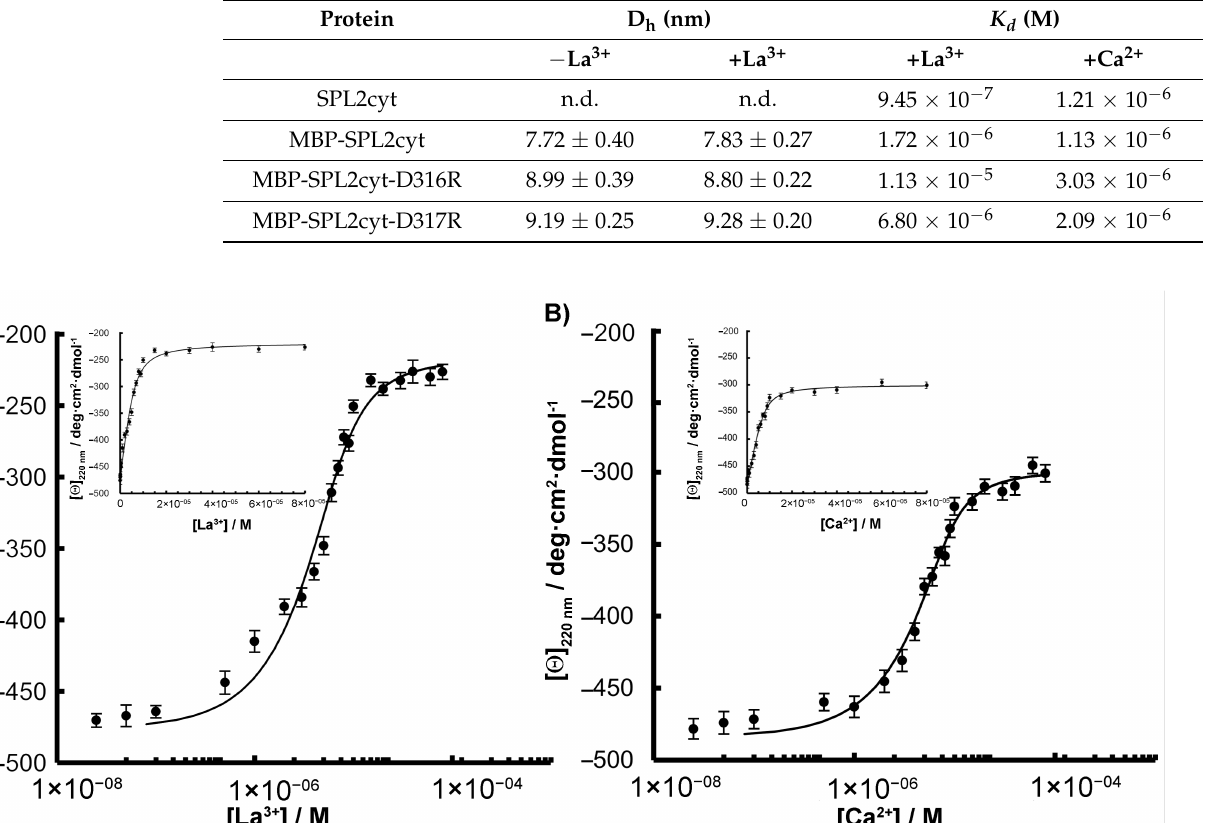
Table 1. Hydrodynamic diameter (Dh) in the presence or absence of La3+ and apparent dissociation constant (Kd) of SPL2 and its mutants.